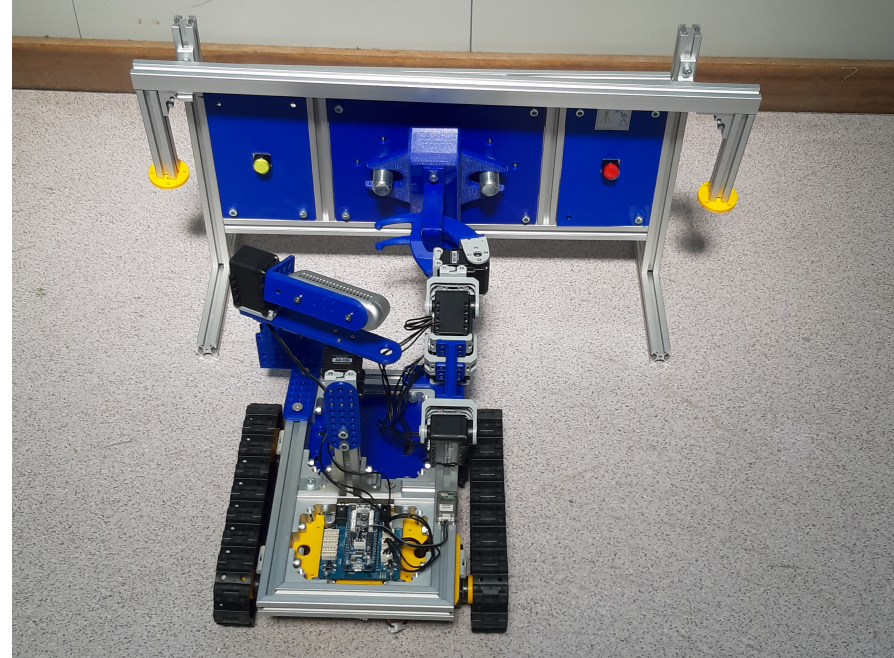
Figure 22. Students uncovering the antimatter factory panel mockup